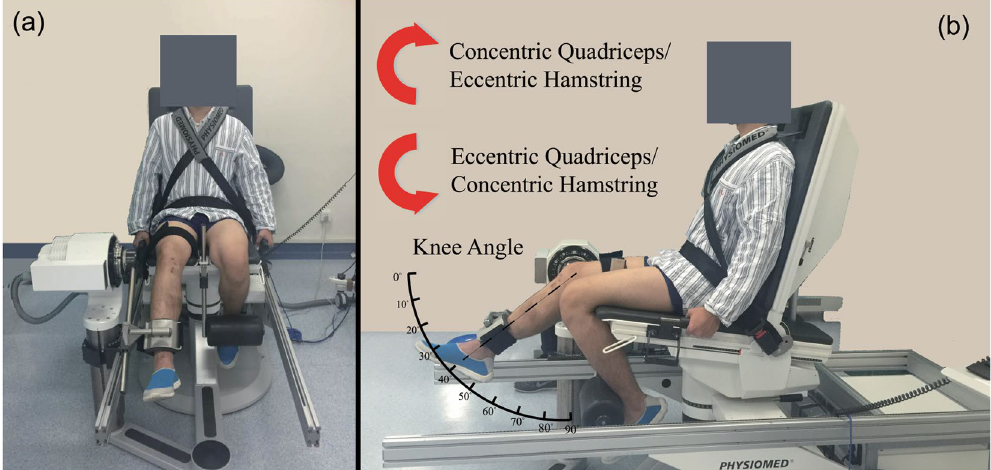
Figure 1. Illustrations of isokinetic test protocol. ( a ) An example of the isokinetic test by a subject and ( b ) an illustration of knee motion and the limb muscle contraction in the isokinetic